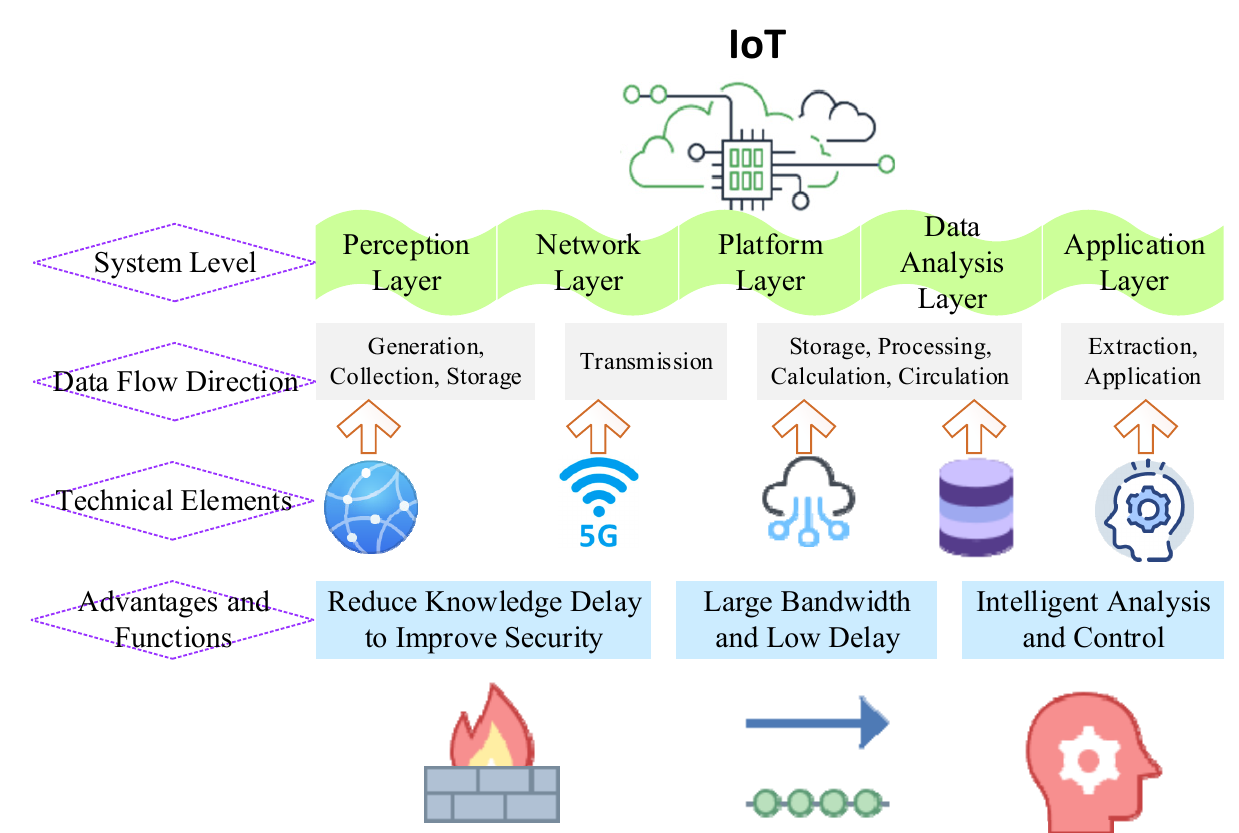
Figure 3. A deconstruction of the IoT’s relationship to multiple